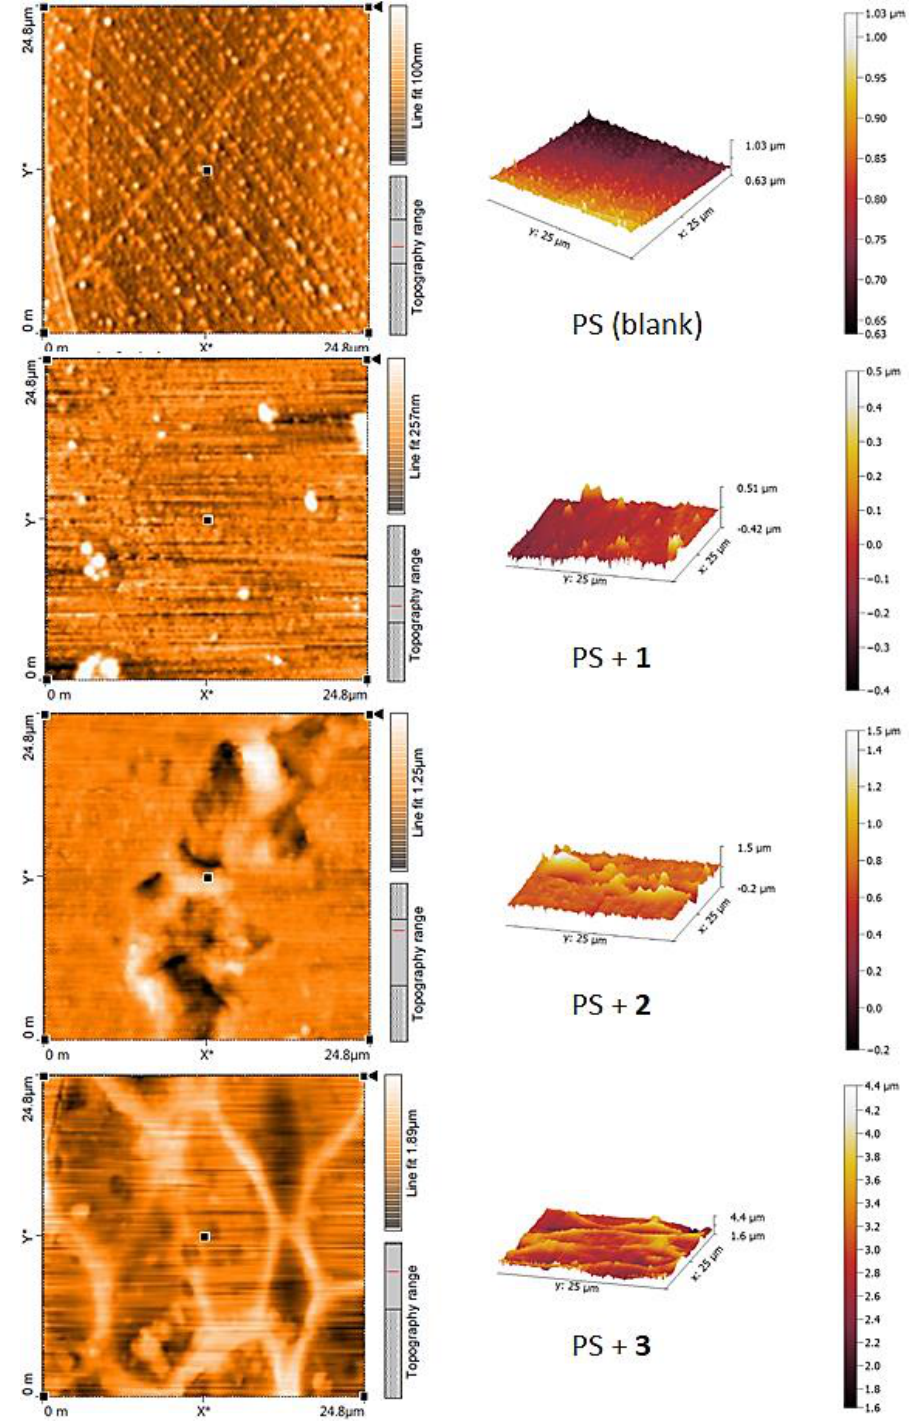
Figure 13. 2D and 3D AFM images of PS and PS/Schiff bases 1 – 3 blends before irradiation.